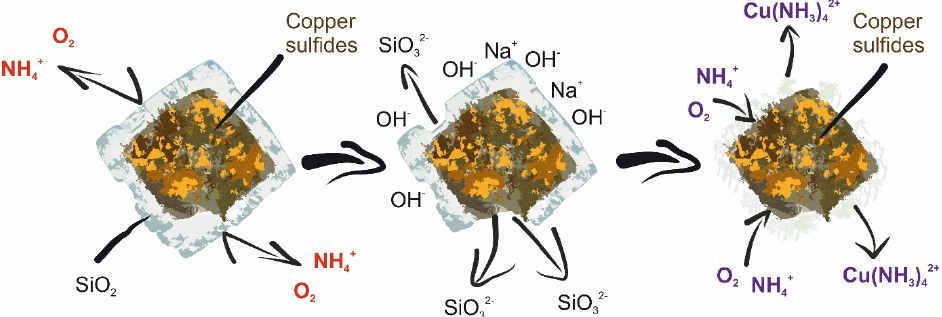
Figure 15. Schematic diagram of the effect of pre-desilication on recovery of Cu and Ag during ammonia leaching.